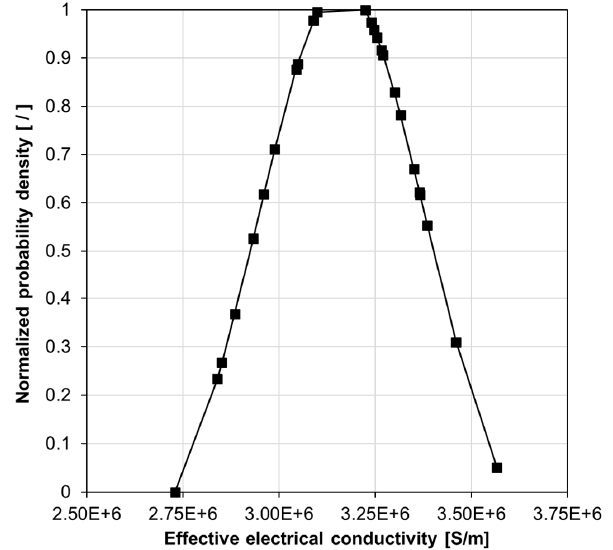
Figure 10. A normalized probability density graph for effective electrical conductivity data of a Table 4. Effective electrical conductivity results and statistical analyses for a silver/epoxy silver/epoxy nanocomposite system with a particle size of 3 nm, tunneling distance of 1.5 nm, and 30 nanocomposite with a particle size of 3 nm, tunneling distance of 1.5 nm, and 30 vol% filler loading. vol% filler